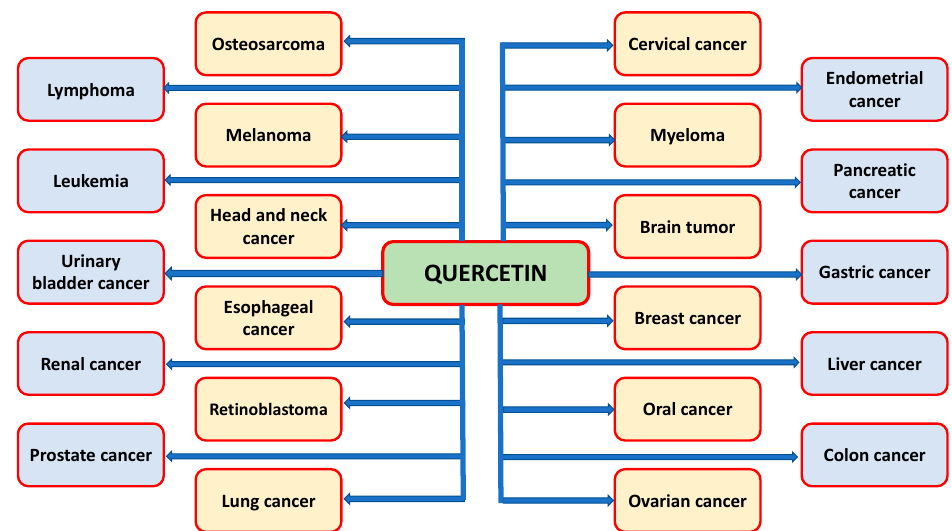
Figure 3. Quercetin has a proven anticancer role in multiple cancers, based on in vivo and in vitro studies.